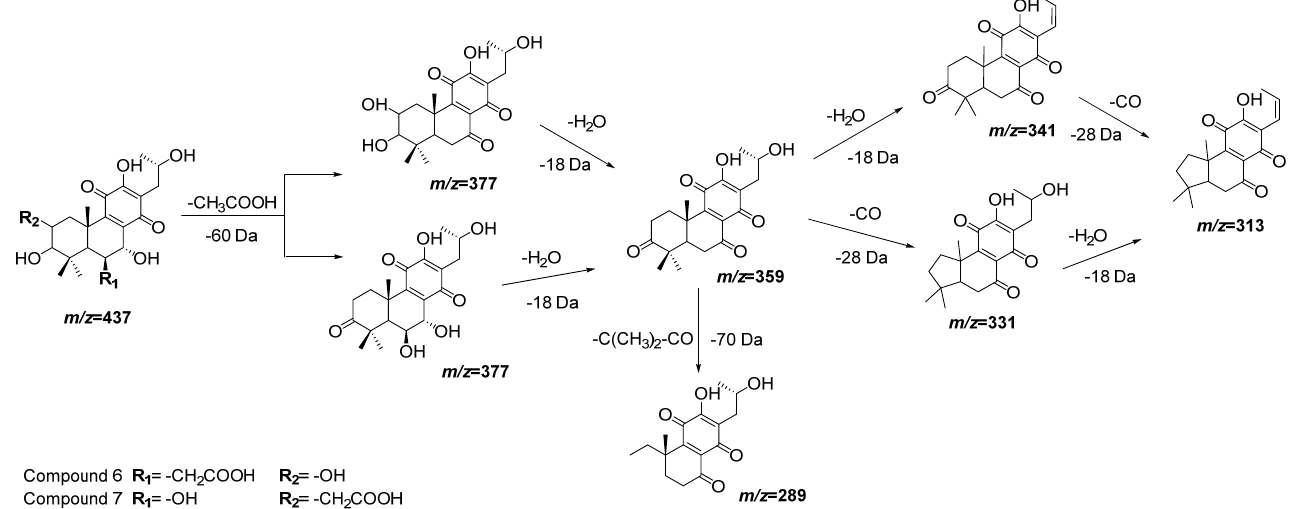
Figure 4. Fragmentation pathways (ESI negative mode) proposed for compounds 6 and 7 in Plectranthus neochilus extracts.